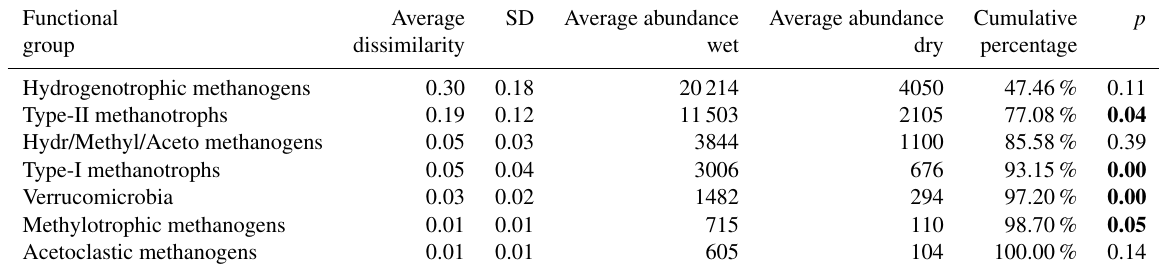
Table 5. Results of SIMPER analysis between wet ( n = 4) and dry ( n = 6) plots. Taxa are ranked according to their average contribution to dissimilarity between plots. Standard deviation (SD), average abundances, percentage of cumulative contribution, and the permutation p value (probability of obtaining a larger or equal average contribution in random permutation of the group factor) are also